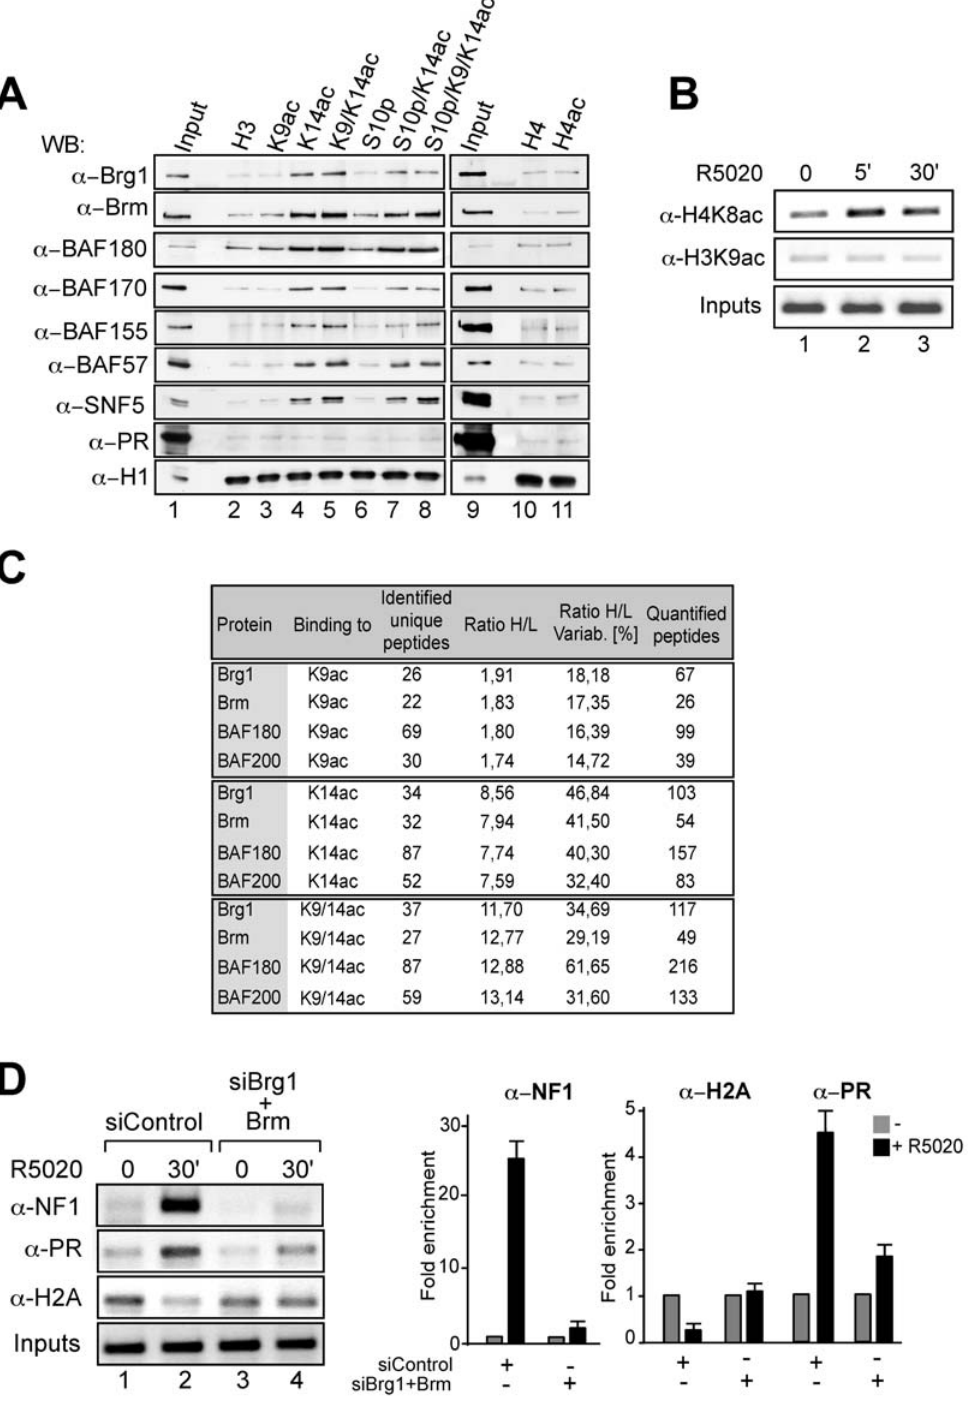
Figure 4. The BAF complex binds preferentially to histone H3K14ac and promotes H2A displacement. (A) Nuclear extracts derived from T47D-MTVL cells were used for pulldown experiments with the indicated H3 and H4 tail peptides coupled to beads. Immunoblotting was performed for the presence of components of the BAF and PBAF complex, histone H1 and PR. (B) Cells were untreated (0) or treated for 5 and 30 min with 10 nM R-5020 and subjected to ChIP assays with a -H4K8ac and a -H3K9ac specific antibodies. The precipitated DNA fragments were subjected to PCR analysis to test for the presence of sequences corresponding to the MMTV nucleosome B. Input material (1%) is shown for comparison. A representative of three independent experiments is shown. (C) Quantification of the interaction of selected human SWI/SNF subunits with the indicated H3 tail acetylated peptides. SILAC ratios represent the relative abundance of the ‘heavy’ (modified) to the ‘light’ (unmodified) peptide. The variation (in %) and the number of quantified peptides are indicated. (D) Left: T47D-MTVL cells were transfected with siRNAs and treated with hormone as indicated, subjected to ChIP assays using a -NF1, a -PR and a -H2A and primers for MMTV nucleosome B. Right: quantification of the results by real time PCR. A representative of three independent experiments is